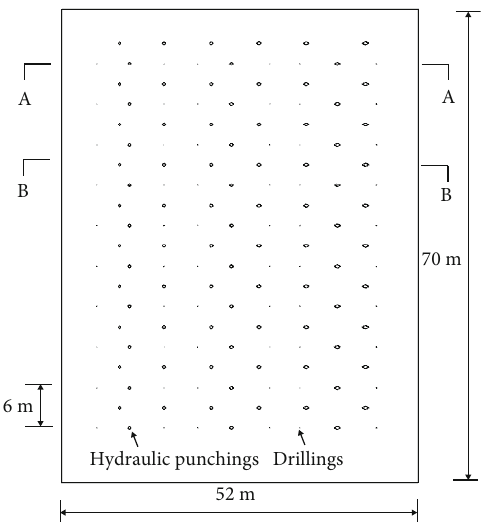
Figure 3: Gas extraction layout of integrated drillings and punchings from the fl oor roadway.